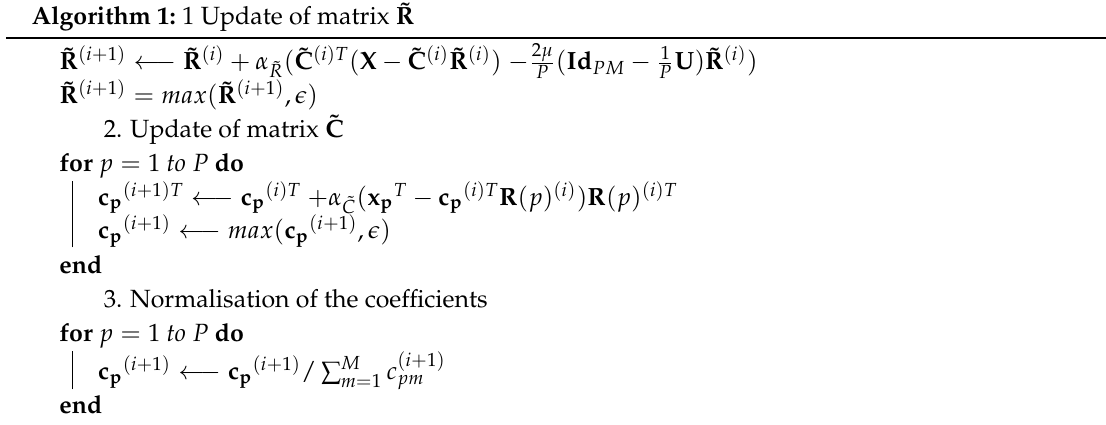
Algorithm 1: 1 Update of matrix